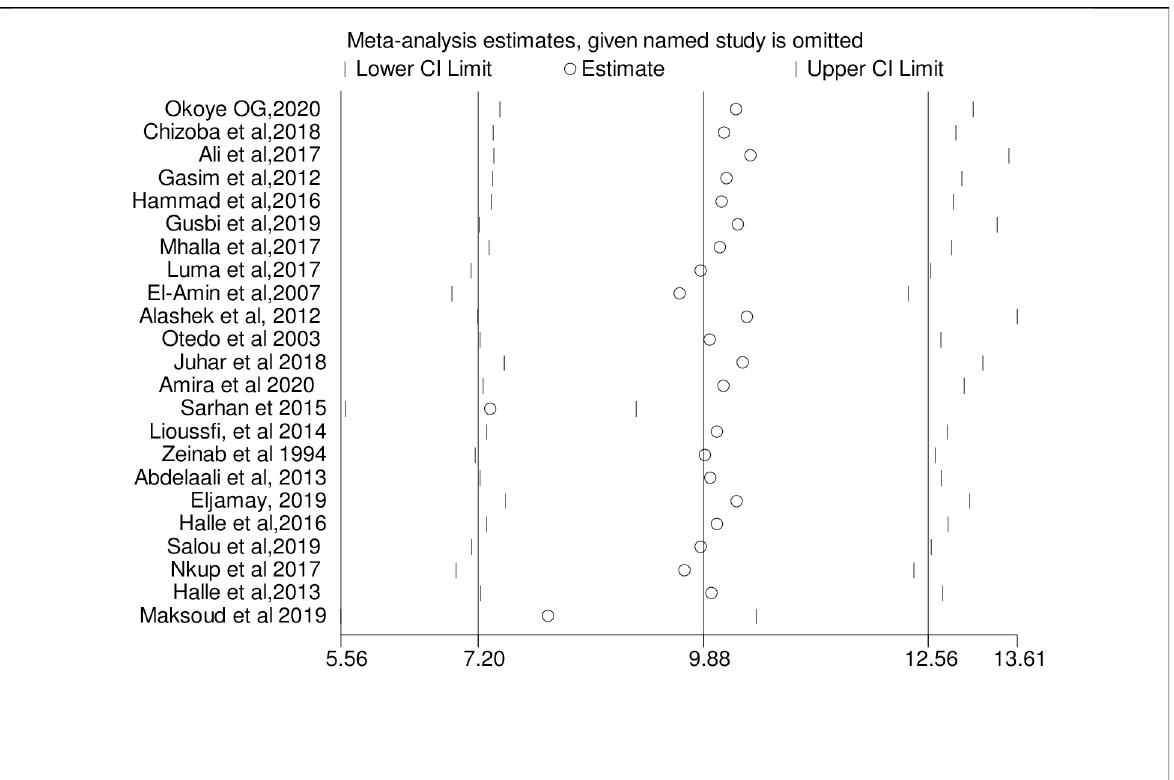
Fig 6. Sensitivity analysis of the included studies to estimate the pooled prevalence of HBV among HD patients.